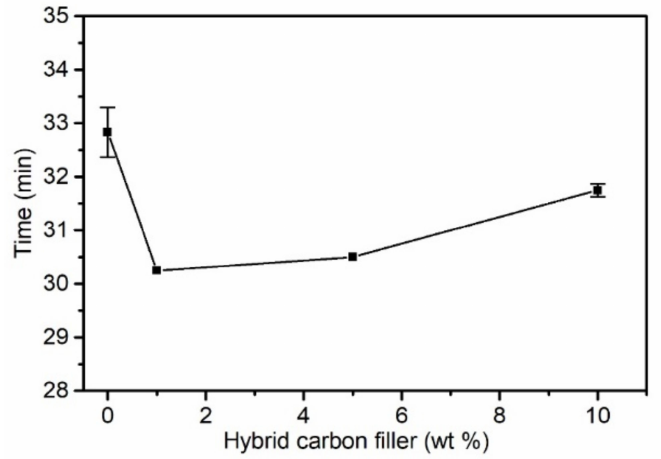
Figure 5. Time of thermal stability as a function of hybrid filler concentration in PVC